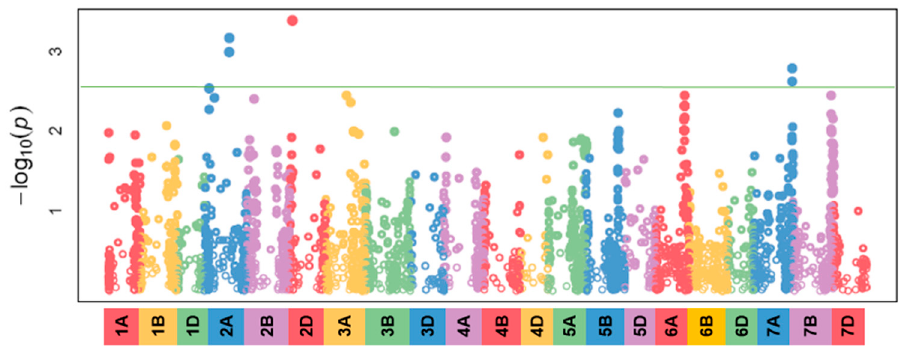
Figure 2. Manhattan plot, average infection values on the 21st day after inoculation under field conditions, according to the chromosomal localization of the markers (level of significance: -log 10 ( p ) 2,5; Martonvásár, 2009, 2011).